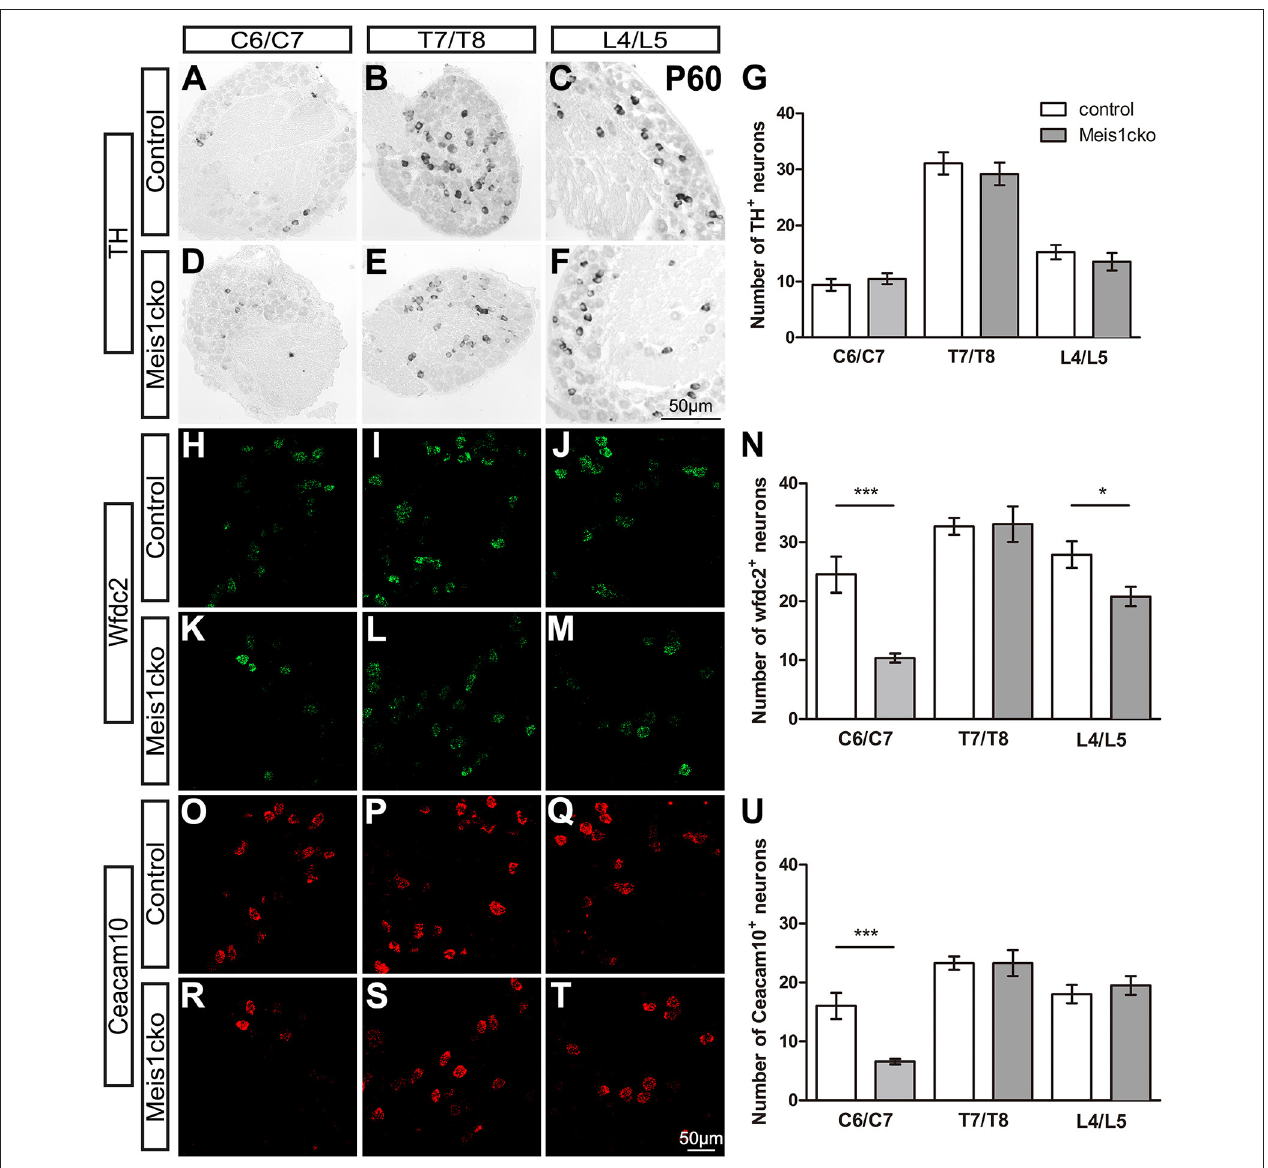
FIGURE 4 | Expression of C-LTMR-specific markers in Meis1cko and control DRGs at different axial levels. (A–U) ISH and RNAscope were used to examine the expression of TH , Wfdc2 and Ceacam10 in cervical (C6/C7), thoracic (T7/T8) and lumbar (L4/L5) DRGs from 3 pairs of P60 Meis1cko and control mice. (A–G) TH expression was unchanged at different axial levels. (H–N) The number of Wfdc2 + neurons was significantly decreased in cervical and lumbar DRGs (in C6/C7: 24.5 ± 3.1 in control mice, 10.4 ± 0.8 in Meis1cko mice, p < 0.0001; in L4/L5: 27.9 ± 2.3 in control mice, 20.8 ± 1.6 in Meis1cko mice, p = 0.0131). (O–U) The number of Ceacam10 + neurons was obviously reduced in cervical DRGs (16.0 ± 2.2 in control mice, 6.6 ± 0.5 in Meis1cko mice, p < 0.0001). Error bars represent the SEM. Significant differences were determined using unpaired Student’s t -test: * p < 0.05 and *** p < 0.001. ns, Not significant. Scale bar: 50 µ